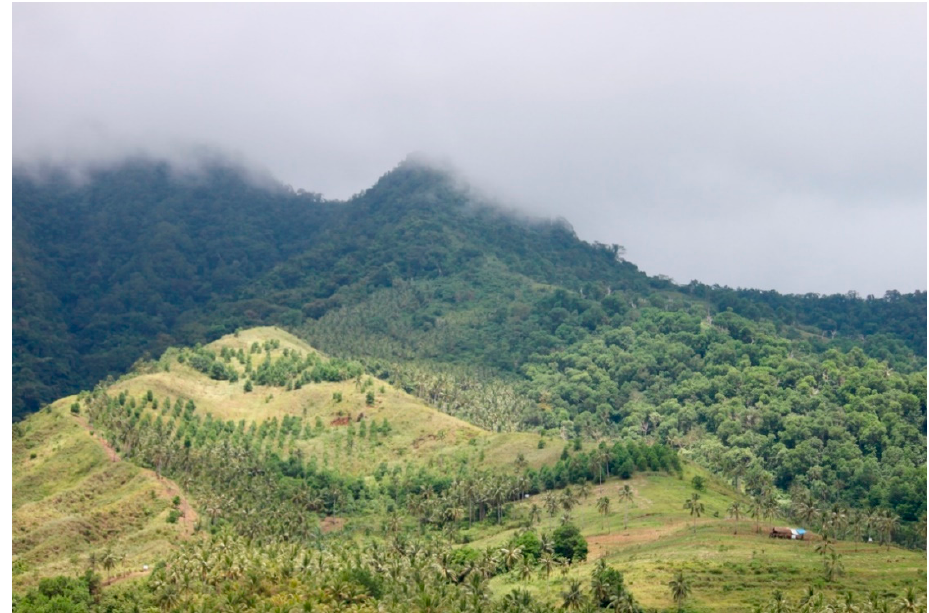
Figure 2. Pilot reforestation site in Biliran island, the Philippines (Photo: Sharif A. Mukul).